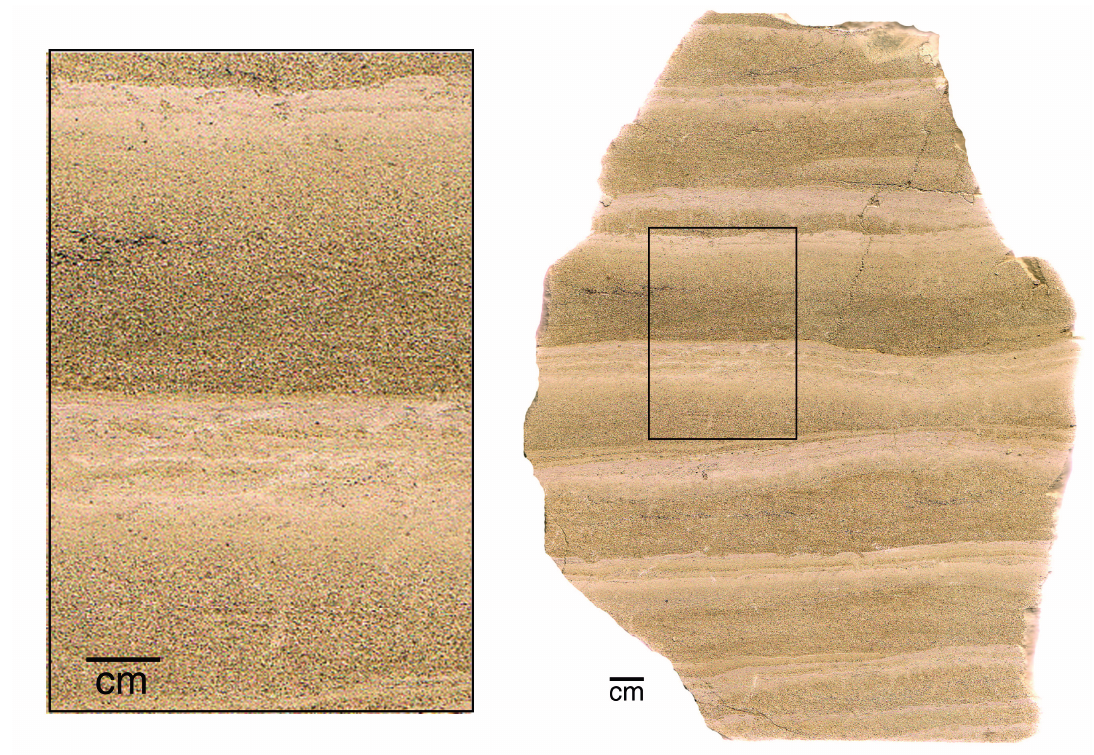
Figure 12. Cyclic sedimentation in Boot Hill locality transition zone between middle mudstone unit and upper lithic sandstone unit (specimen WWU